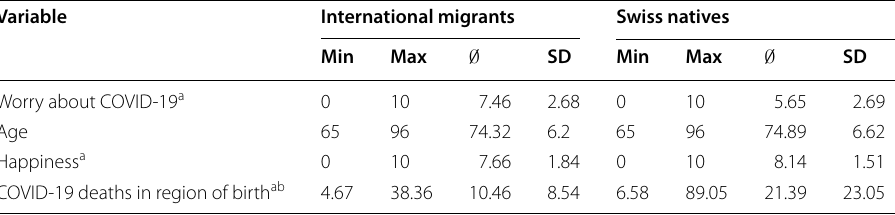
Source : TransAge Survey 2020 a Significant difference between international migrants and Swiss natives b This variable indicates the COVID‑19 deaths in the canton of residence for Swiss natives